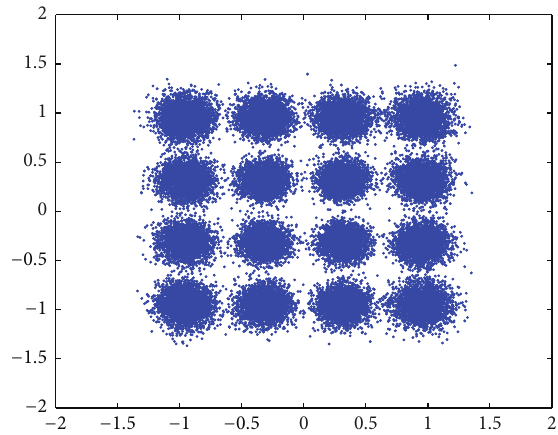
Figure 11: Received constellations of legitimate receiver for multi- path optical wireless channel.